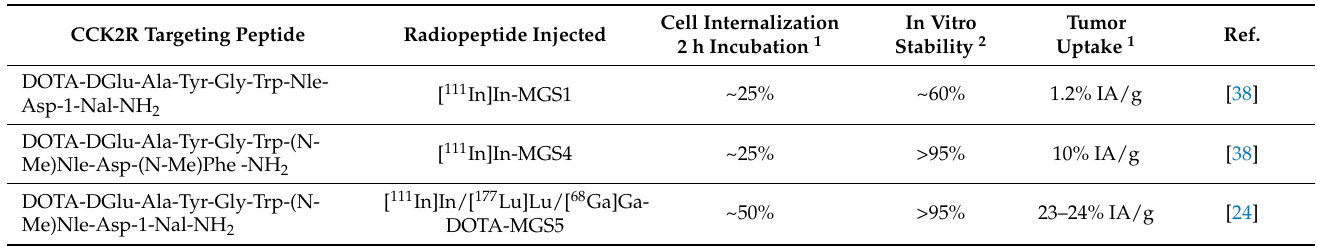
Table 3. Targeting properties of selected radiolabeled MG analogs with substitutions within the C-terminal sequence. CCK2R Targeting